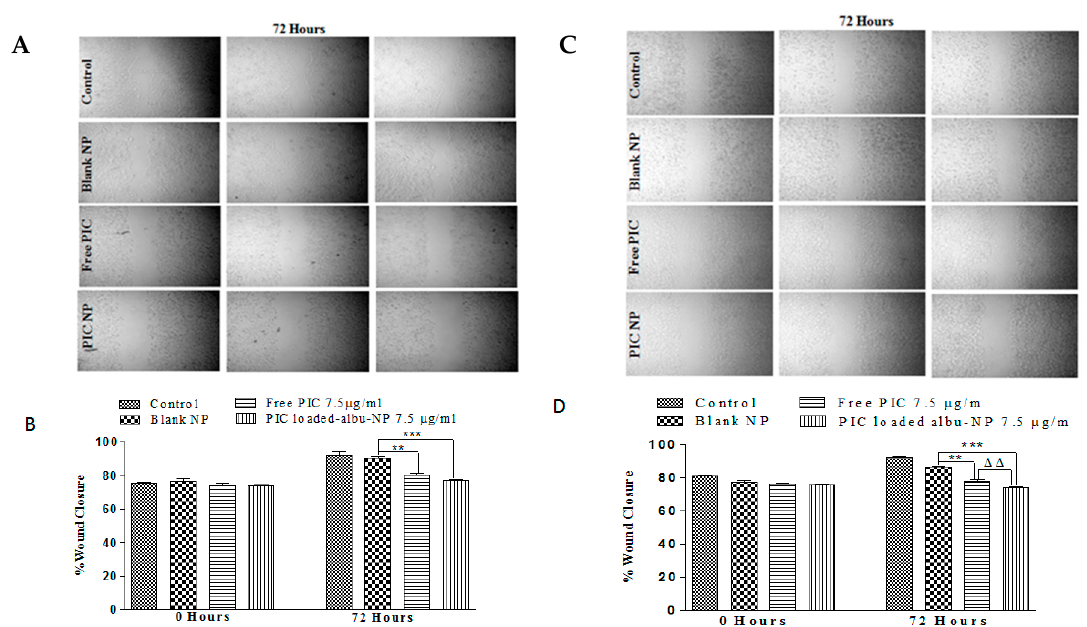
Figure 2. E ff ect of PIC-loaded albumin nanoparticles on migration potential. E ff ect of PIC-loaded albumin NPs and free PIC on migration potential of CaCo-2 cell lines. The above image in ( A ) demonstrates the e ff ect of free PIC and PIC-loaded albumin NPs on wound closure after 72 h of treatment. PIC-loaded albumin NPs demonstrate more void space than free PIC in the wound scratch of cell lines as compared to control and blank NPs. ( B ) depicts a significant variation of anti-migration activity of free PIC ( p < 0.01) and PIC-loaded albumin NPs ( p < 0.001) after 72 h of treatment at equal dose. Values are mean ± SEM with n = 3. ** p < 0.01, *** p < 0.001 compared with blank NPs. Similarly, ( C , D ) represents the e ff ect of PIC-loaded albumin NPs and free PIC on migration potential of HT-29 cell lines. ( C ) shows the e ff ect of free PIC and PIC-loaded albumin NPs on wound closure after 72 h of treatment. PIC-loaded albumin NPs demonstrate more void space than free PIC in the wound scratch of cell lines as compared to control and blank NPs. ( D ) shows a significant variation of anti-migration activity of free PIC ( p < 0.01) and PIC-loaded albumin NPs ( p < 0.001) after 72 h of treatment at equal dose. Values are mean ± SEM with n = 3. ** p < 0.01, *** p < 0.001 compared with blank NPs and ∆∆ p < 0.01 compared with the same dose of free PIC.